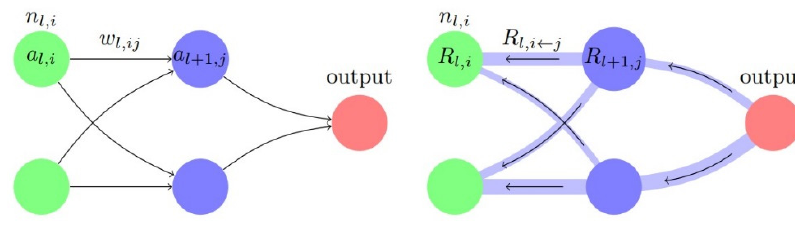
Figure 5. Model prediction and relevance calculation.